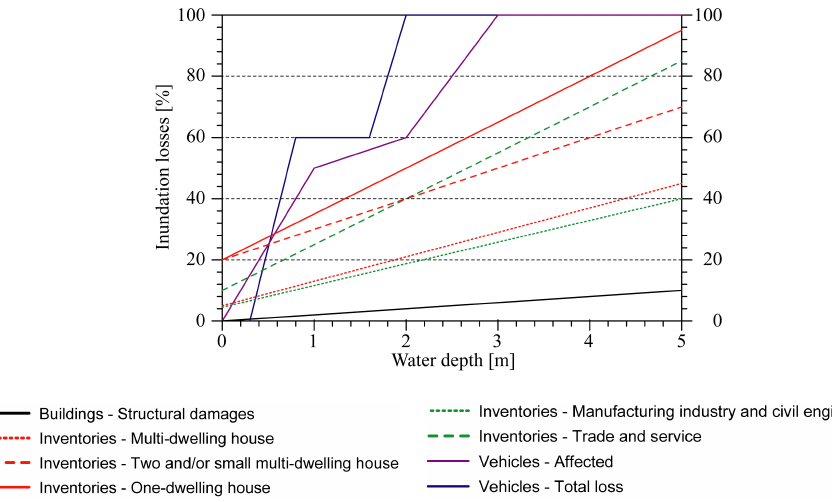
Fig. 5. Damage functions following the MURL concept (adapted according to MURL, 2000).